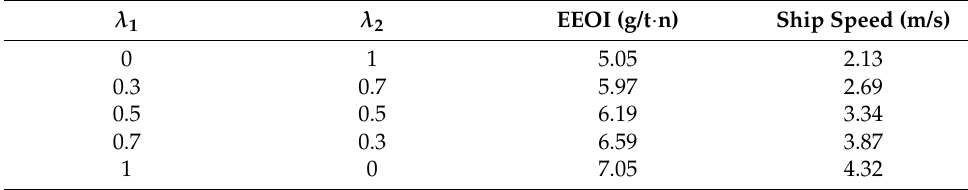
Figure 7. Absolute error of ship speed prediction. Table 3. Optimization results under different parameter selection. Table 3. Optimization results under different parameter selection.